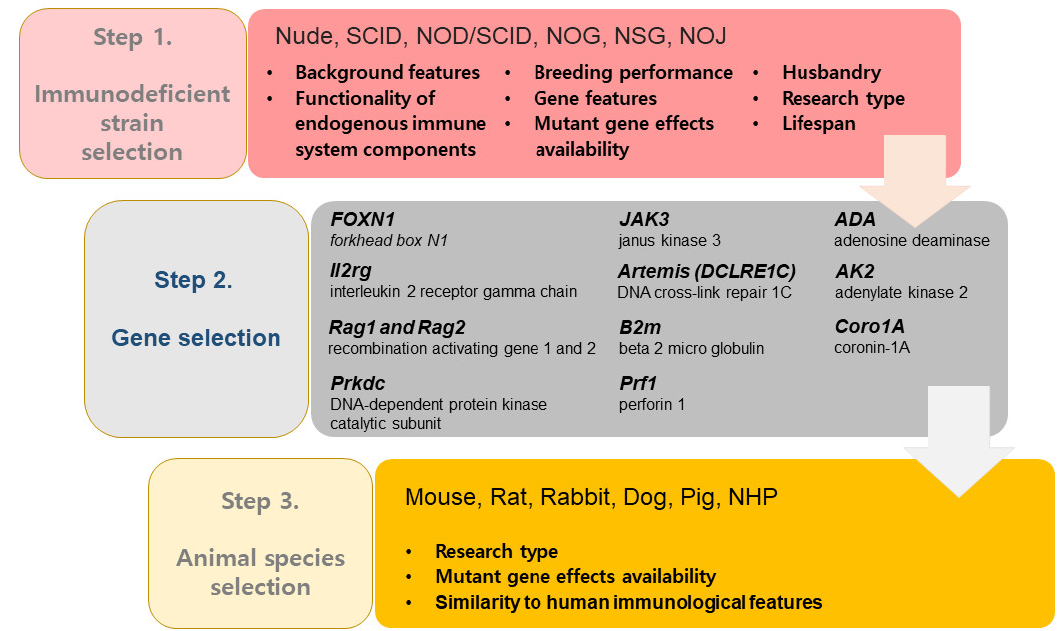
Figure 2. The process of proper immunodeficient animal selection for biomedical research.